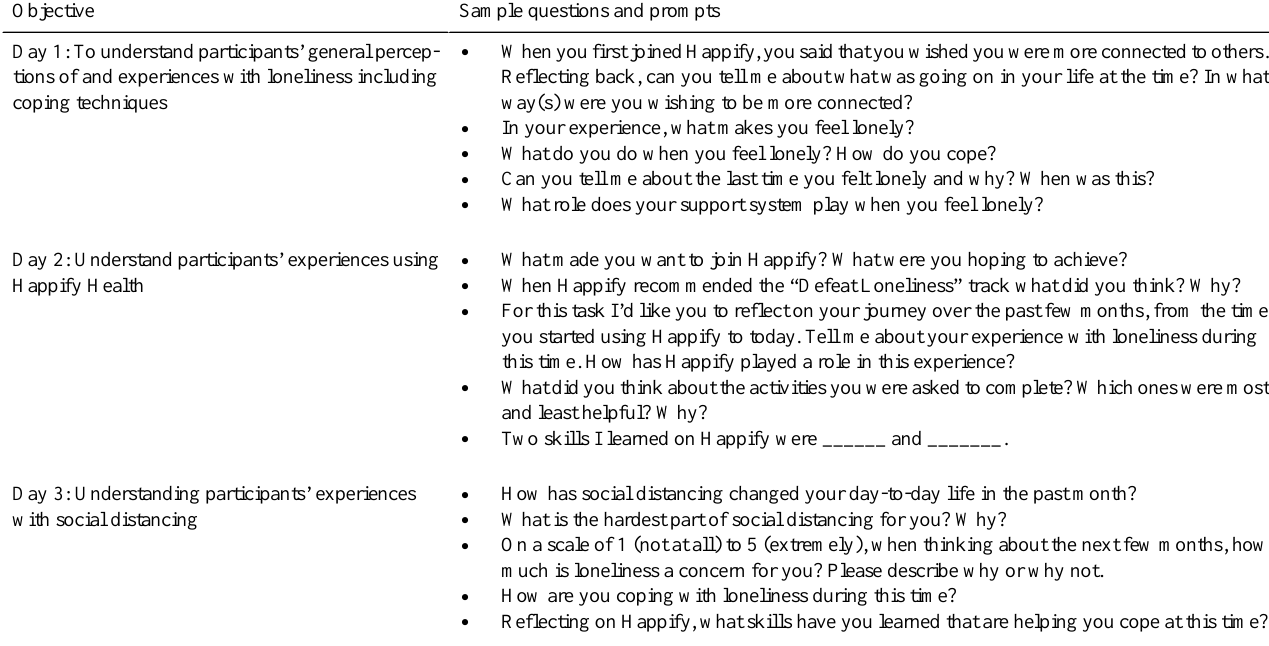
Table 1. Objective and sample questions or prompts by focus group day.